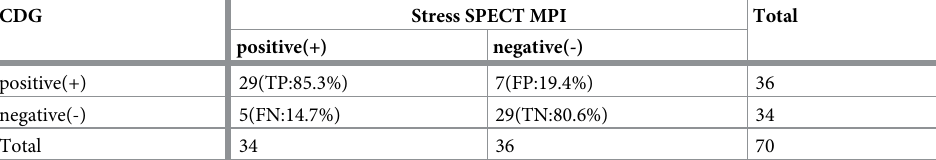
Table 3. Correlation between CDG and stress SPECT. CDG Stress SPECT MPI Total positive(+) negative(-) positive(+) 29(TP:85.3%) 7(FP:19.4%) 36 negative(-) 5(FN:14.7%) 29(TN:80.6%) 34 Total 34 36 70 Accuracy = 82.9%; Sensitivity = 85.3%; Specificity = 80.6%; Kappa value = 0.658; Positive predictive values (PPV) = 80.6%; Negative predictive values (NPV) = 85.3%; Positive likelihood ratio (LR+) = 4.40; Negative likelihood ratio (LR-) =